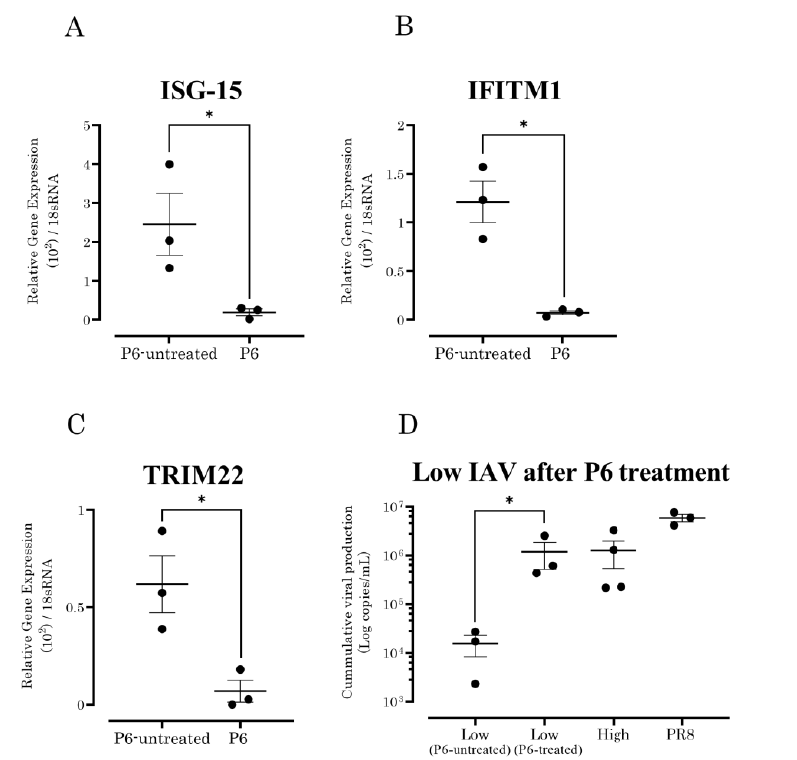
Figure 3. Influence of ISGs on IAVs with low growth capabilities. P6-untreated and P6-treated A549 cells were prepared to observe the JAK/STAT inhibition. Pretreatment of A549 cells with 5 µM P6, a JAK/STAT inhibitor, showed a significant suppression of ( A ) ISG-15 ( p = 0.0479), ( B ) IFITM1 ( p = 0.0061), and ( C ) TRIM22 ( p = 0.0252) after 6 h post-infection of IAV strains with low growth capabil- ities. ( D ) P6 treatment of A549 cells inoculated with IAV strains with low growth capabilities signif- icantly increased ( p = 0.0483) the viral copies compared to P6-untreated cells. p values of ≤ 0.05 is given one asterisk (*).